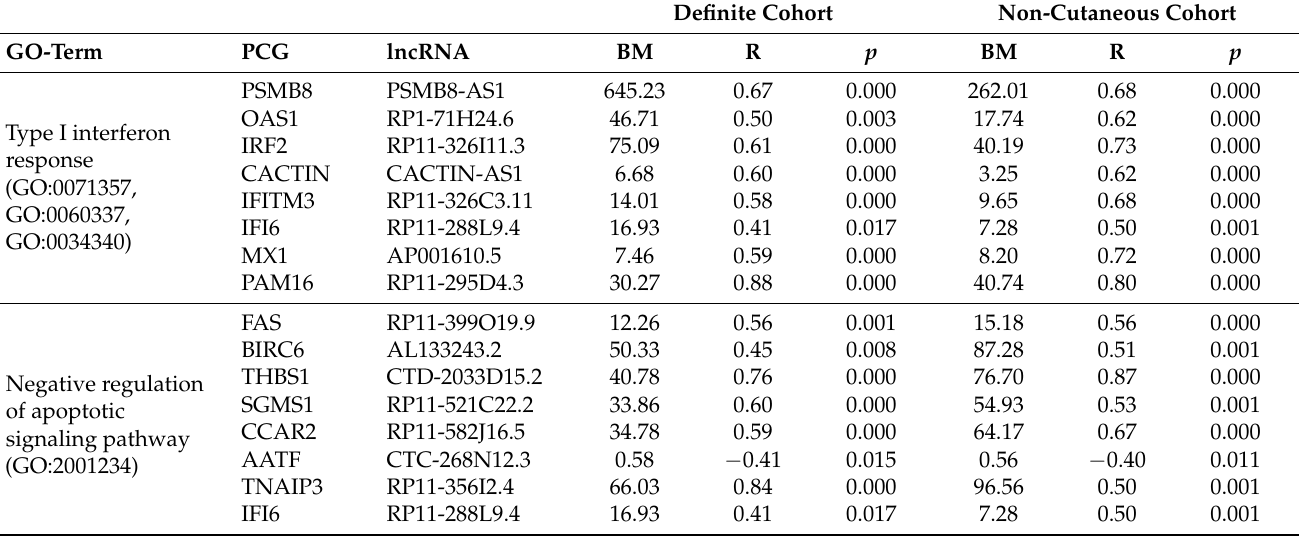
Table 2. Replicated cis correlating lncRNA-PCG pairs are annotated in biological processes relevant for SSc. PCG, protein coding gene; lncRNA, long non-coding RNA; BM, base mean expression level; R, Spearman’s rank correlation coefficient; p , p